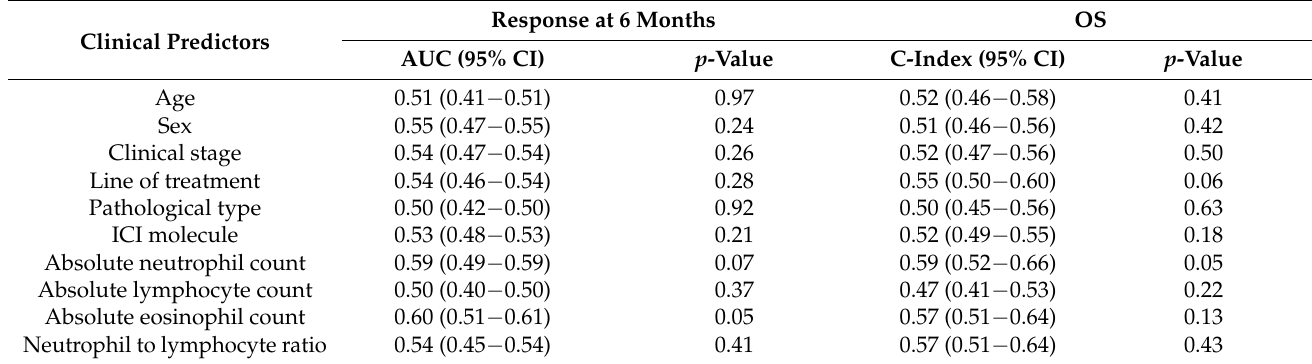
Table 2. Univariate analysis of the clinical